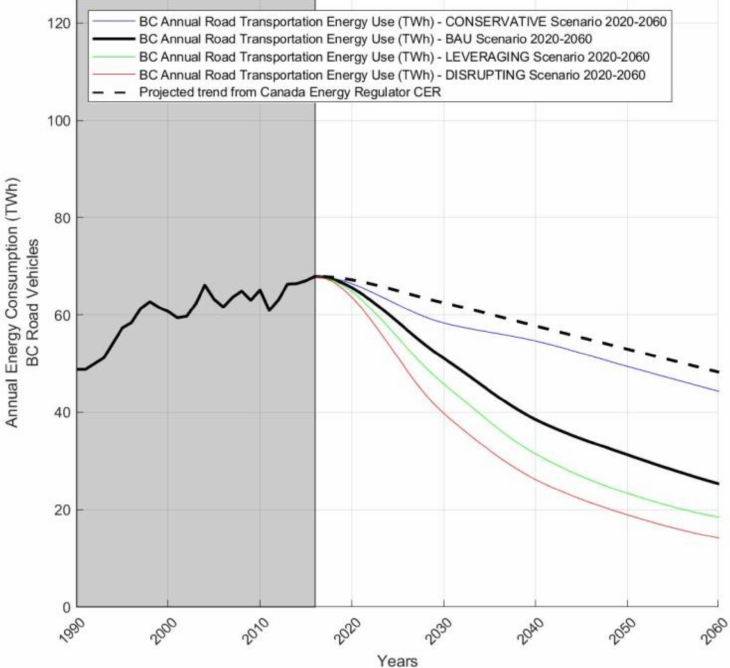
Figure 12. B.C. road transportation annual energy use in (TWh), impacts of vehicle electrification, vehicle automation, and vehicle